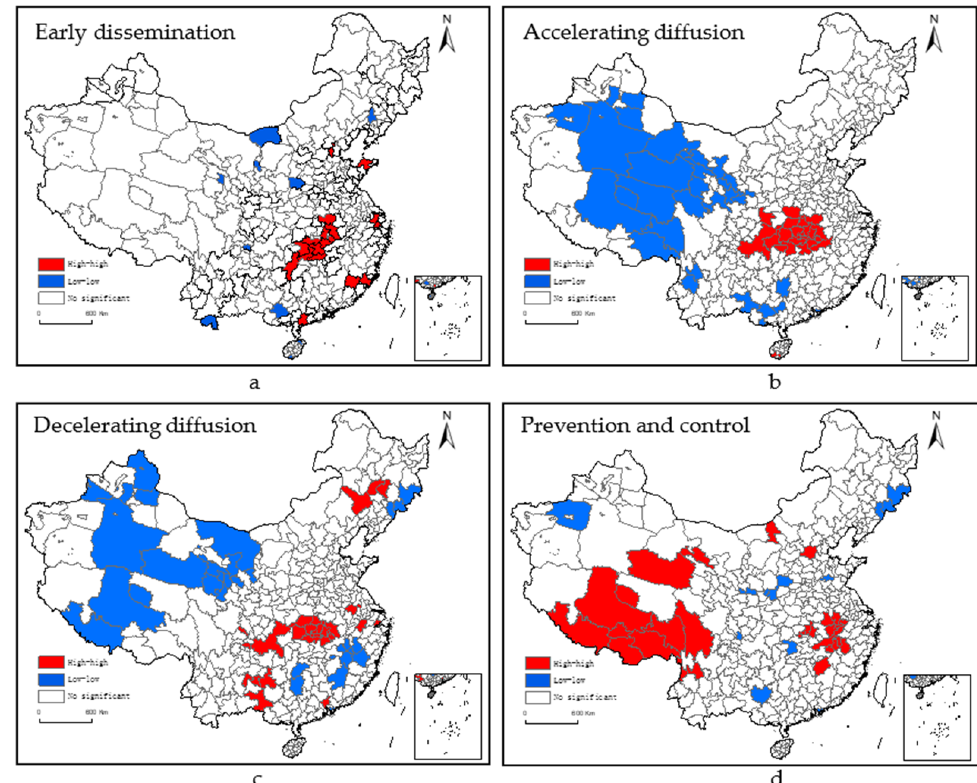
Figure 6. Local indicators of spatial association (Lisa)diagram of local spatial concentration of environmental risk perception.